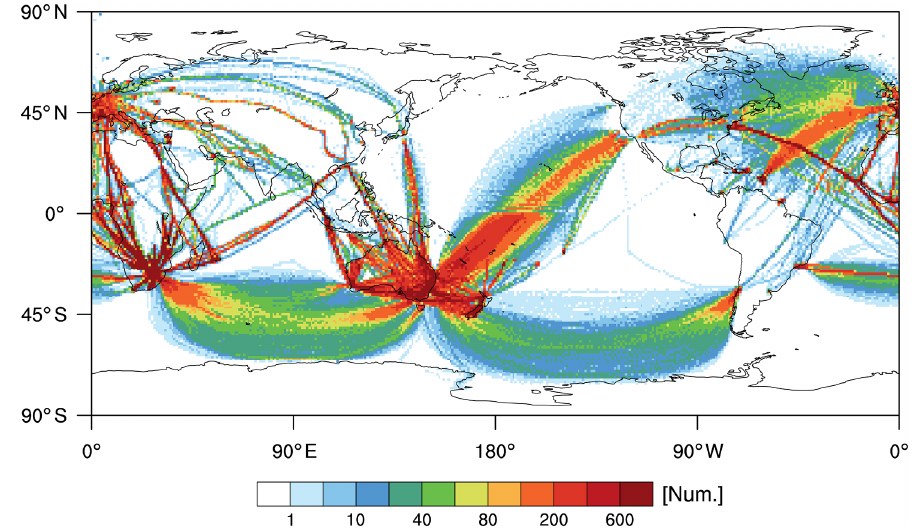
Figure 1. Horizontal distribution of the number of the raw DEVG data at altitudes above 15kft ( ∼ 4 . 57km), accumulated within a 1 ◦ × 1 ◦ horizontal grid box from October 2015 to September 2018.